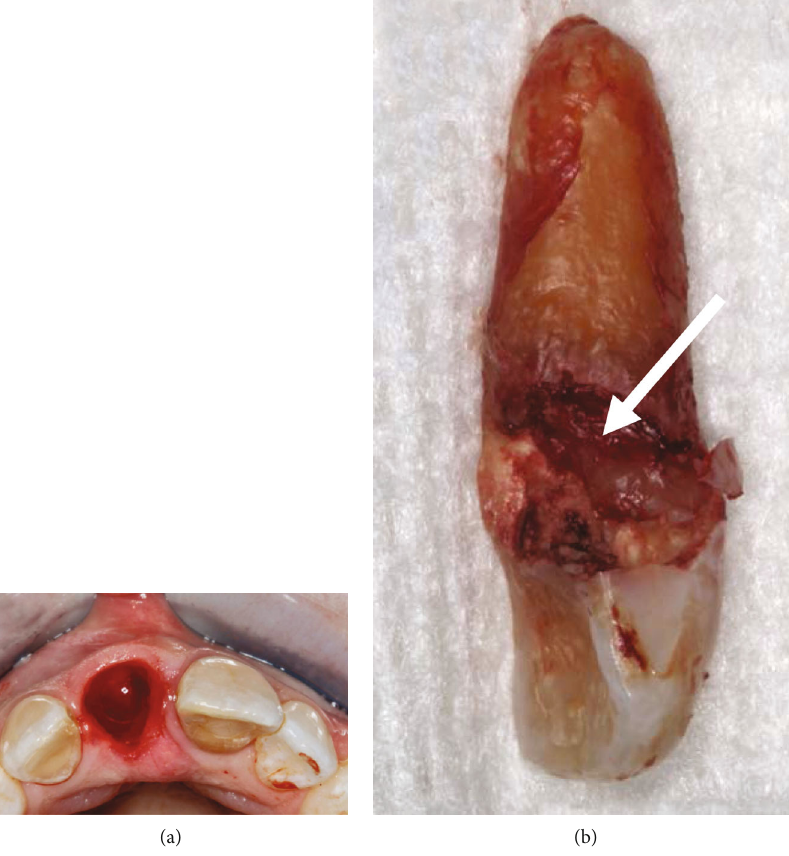
Figure 2: (a) Extraction socket of tooth 11 after minimally invasive tooth extraction without fl ap elevation. (b) External root resorption was observed on the distal surface of the extracted upper right central incisor (white